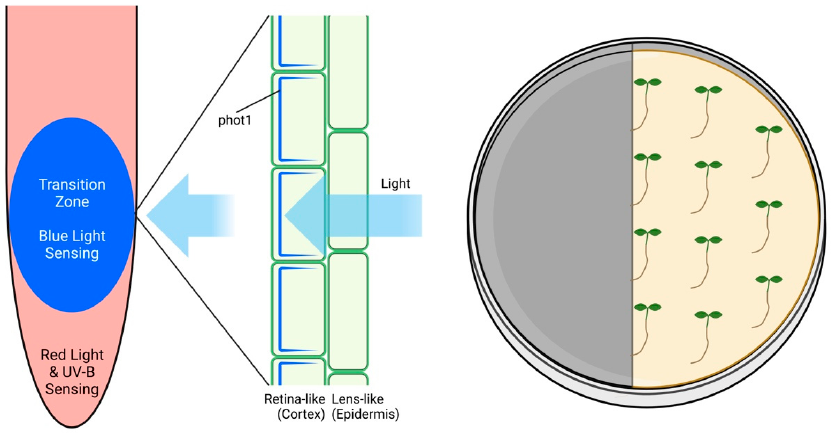
Figure 4. Root Apex Ocelli. Arabidopsis root apex expresses phot1 blue-light photoreceptor in cortex cells of the transition zone. The phot1 photoreceptors are arranged in the U-shape arrangements under the root epidermis cells which are devoid of phot 1 and are proposed to act as a lens cells, focusing the light on the underlying cortex cells. The root apex ocelli are proposed to allow root skototropism when roots grown within the illuminated portion of Petri dish can recognize the dark area and navigate the root growth towards it.